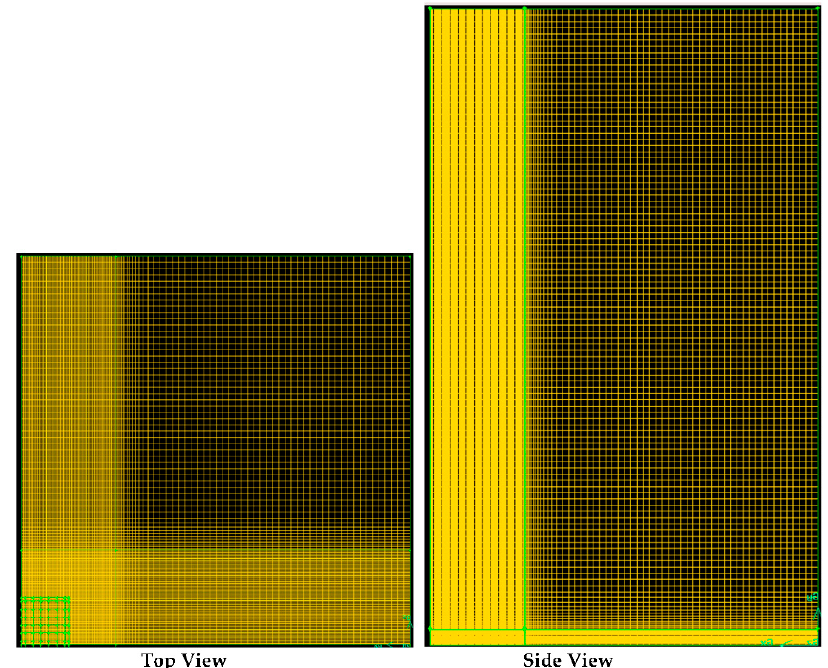
Figure 3. Top and side views for the used mesh in CFD simulations.